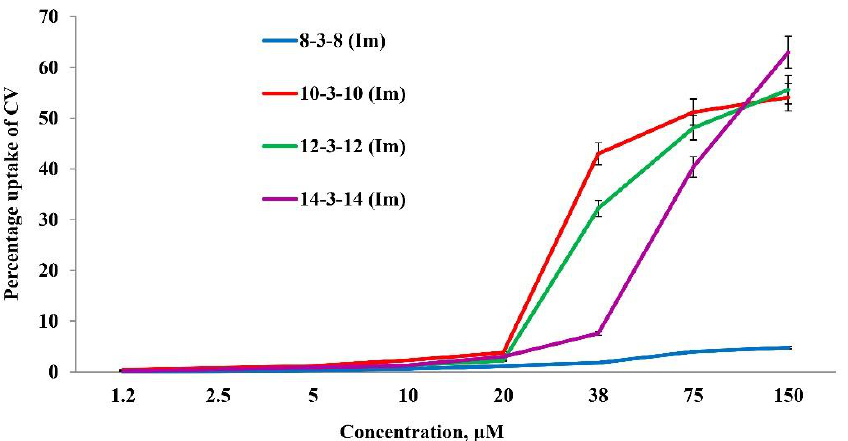
Figure 3. CV uptake analysis. Percentage of CV in supernatant S. aureus after 30 min incubation with compounds of n-3-n(Im) series. The optical density of the dye sample, in the absence of cells, was taken as 100%.